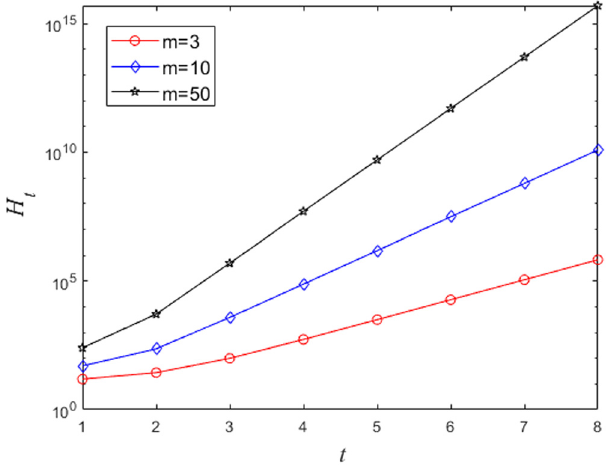
Figure 4: When m is determined, H t increases monotonically with t for ≥ t 0 .